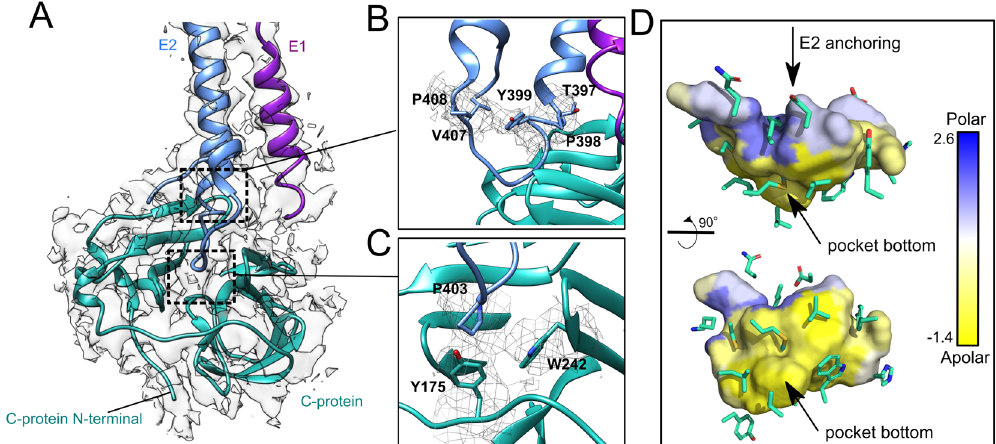
Fig. 7 MAYV capsid interaction with E2 C-terminal domain. A MAYV 3D atomic model fi tted into the cryo-EM density map. C-, E1 and E2 proteins are represented as cyan, purple, and blue cartoon, respectively. B The TPY motif (residues T387, P398 and Y399) interaction with the C protein. C P403 and T402 from E2 and their interaction with aromatic residues Y175 and W242 in C protein. MAYV density map is shown in mesh representation. D Cavity prospection in MAYV C-protein showing a hydrophobic environment in the pocket bottom and a polar and charged environment at cavity outer edges. C- protein cavity that binds E2 C-terminal is in surface representation and is coloured based on the Eisenberg consensus hydrophobic scale. C-protein residues surrounding the cavity are represented as sticks.